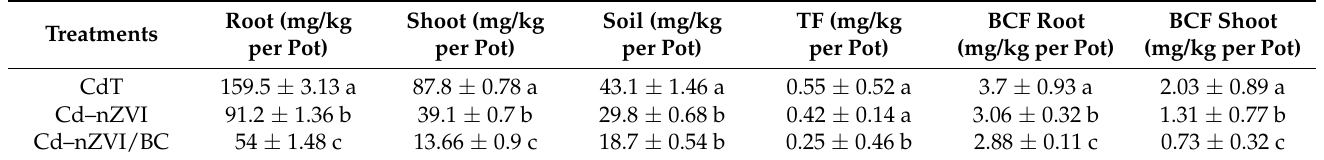
Table 5. Impact of nZVI and nZVI/BC application on Cd uptake and immobilization.